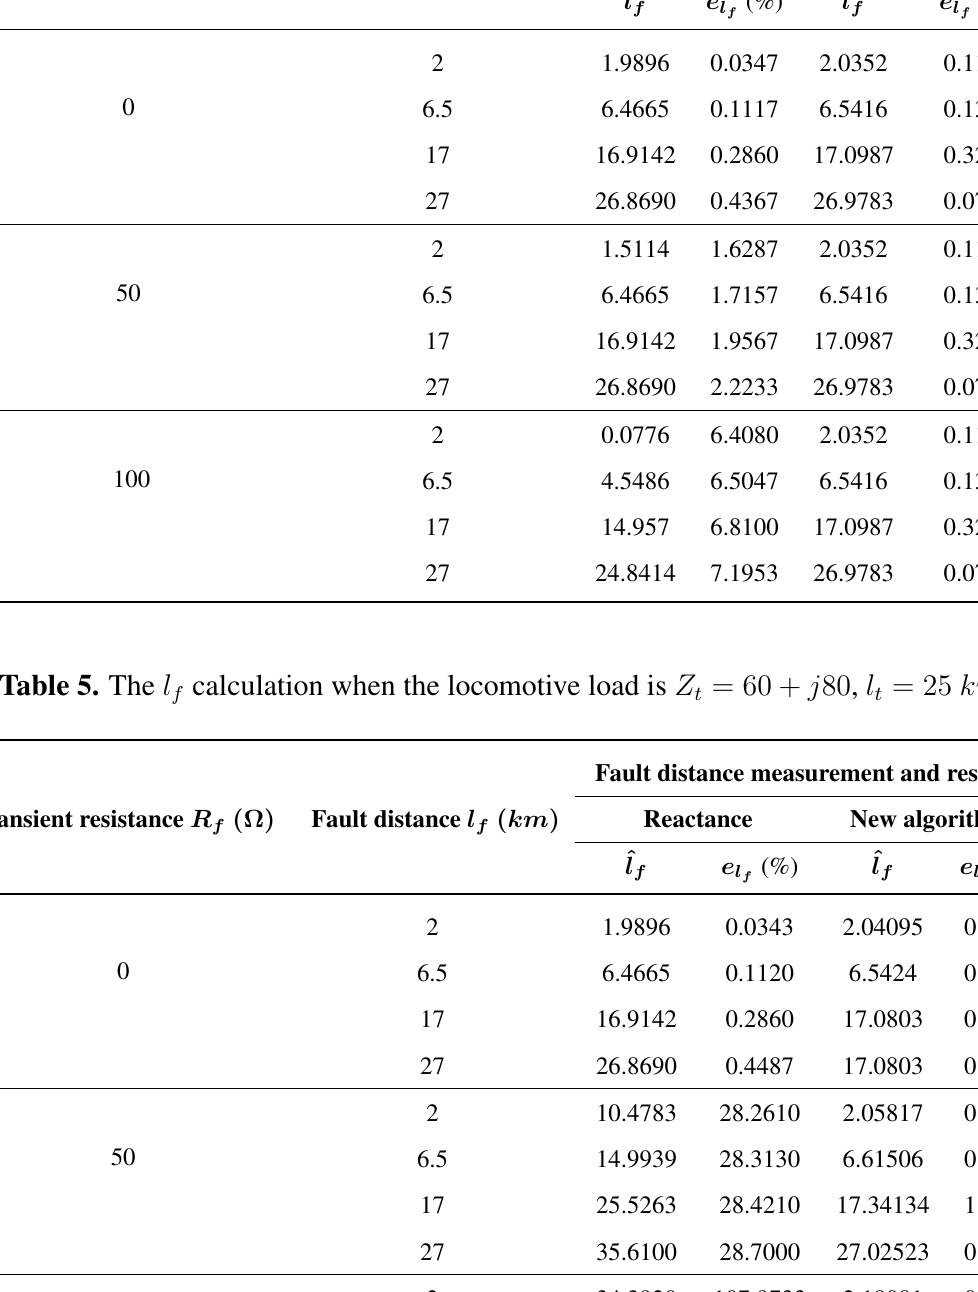
Transient resistance R f (Ω)